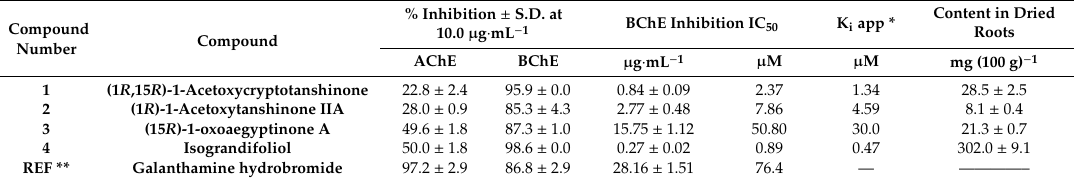
Table 2. Cholinesterase (AChE and BChE) inhibition by the four isolated compounds ( 1 – 4 ) and